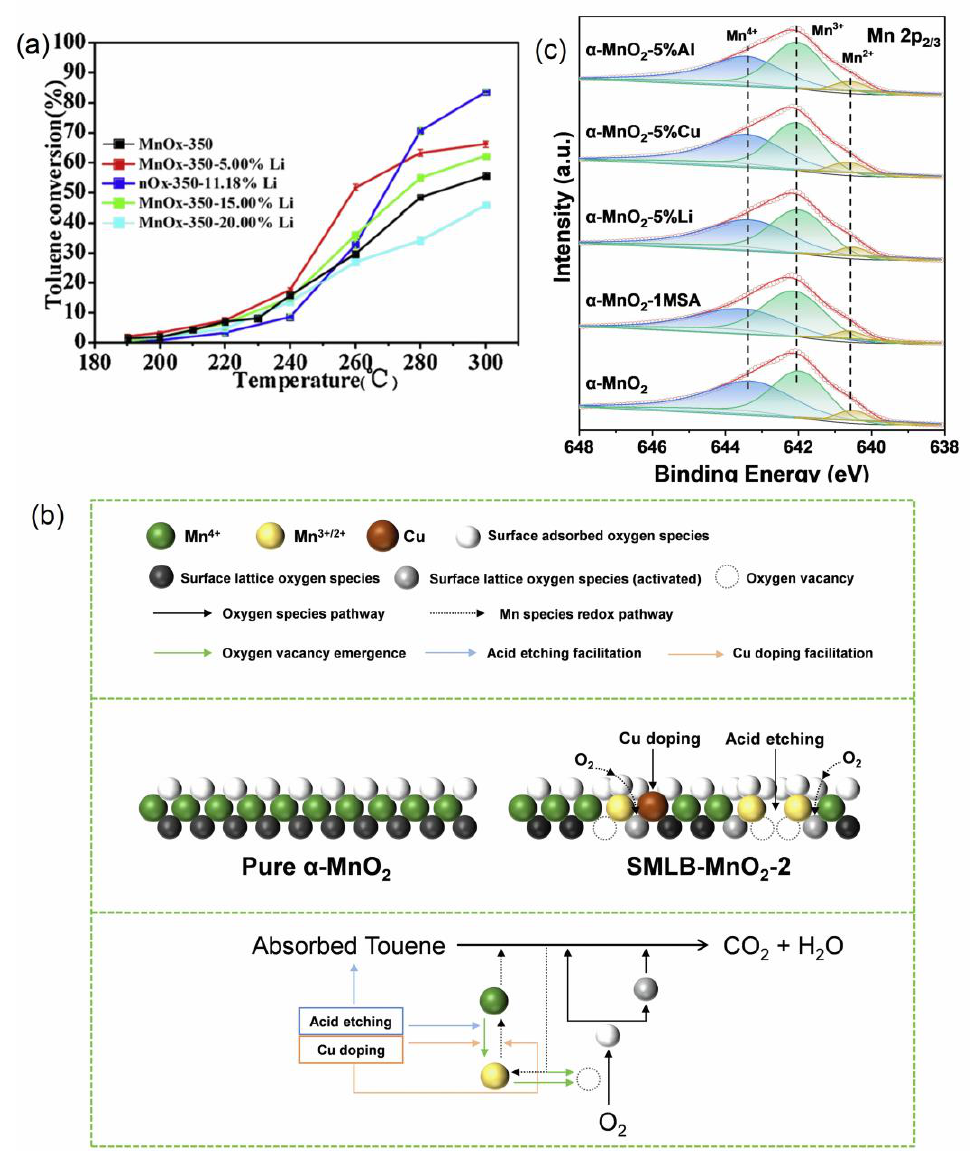
Figure 7. ( a ) The effect of different Li doping percentages on toluene oxidation, ( b ) proposed catalytic mechanism of toluene oxidation on SLMB-MnO 2 -2, and ( c ) XPS spectra of Mn 2p3/2. Reprinted with permission from ref [23,102].